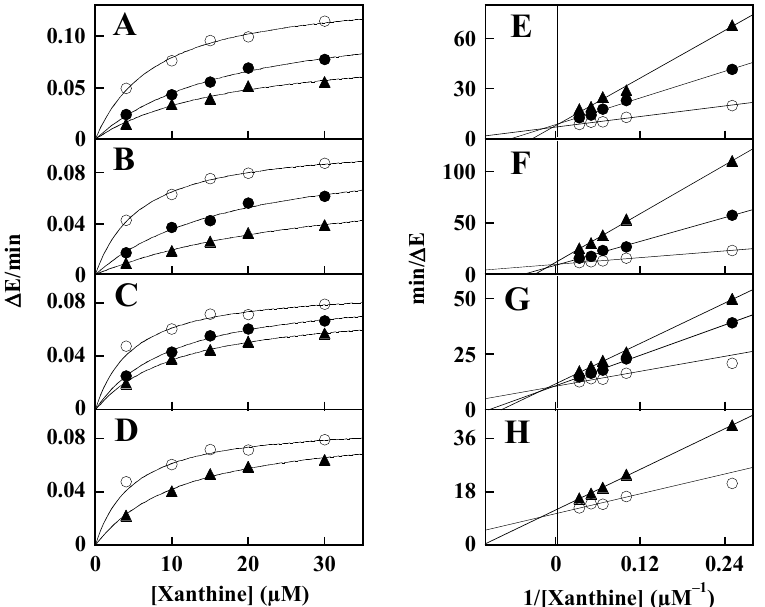
Figure 4. Kinetic analysis of the xanthine oxidase inhibition by ALS-28 , -8 , -15 or -1 . The XO activity (12.5 mU) was measured in the presence of 4–30 µ M xanthine through the initial rate of uric acid formation in the absence (open circles) or presence (filled symbols) of fixed concentrations of the various inhibitors. Panels ( A ) and ( E ), effect of 3 µ M (filled circles) or 10 µ M (triangles) ALS-28 . Panels ( B ) and ( F ), effect of 7.5 µ M (filled circles) or 25 µ M (triangles) ALS-8 . Panels ( C ) and ( G ), effect of 12 µ M (filled circles) or 30 µ M (triangles) ALS-15 . Panels ( D ) and ( H ), effect of 30 µ M (triangles) ALS-1 . Data were reported using the hyperbolic Michaelis–Menten equation (panels ( A )–( D )) or the linear Lineweaver–Burk representation (panels ( E )–( H )). The correlation coefficients R ranged in the interval 0.966–0.998 (non-linear fit the Michaelis–Menten equation) or 0.966–0.999 (linear fit the Lineweaver–Burk plot); other details are described in Materials and Methods. Table 2. Kinetic parameters and inhibition constants of the novel xanthine oxidase inhibitors.